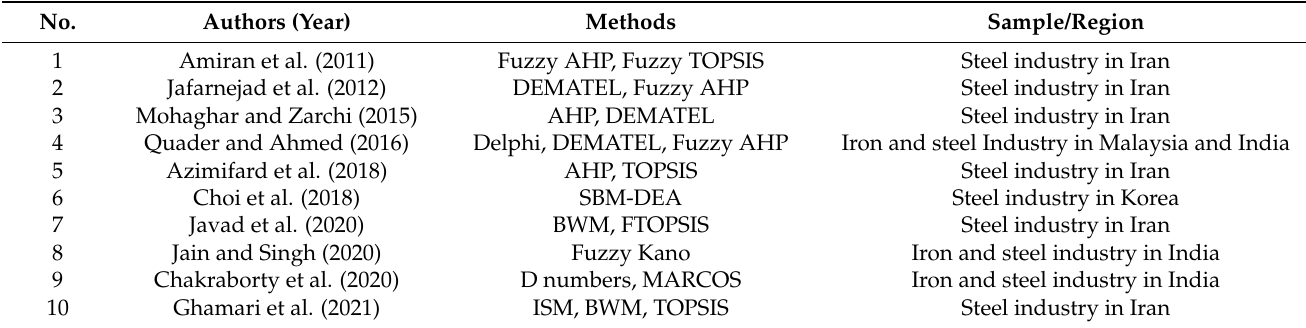
Table 1. A summary of related